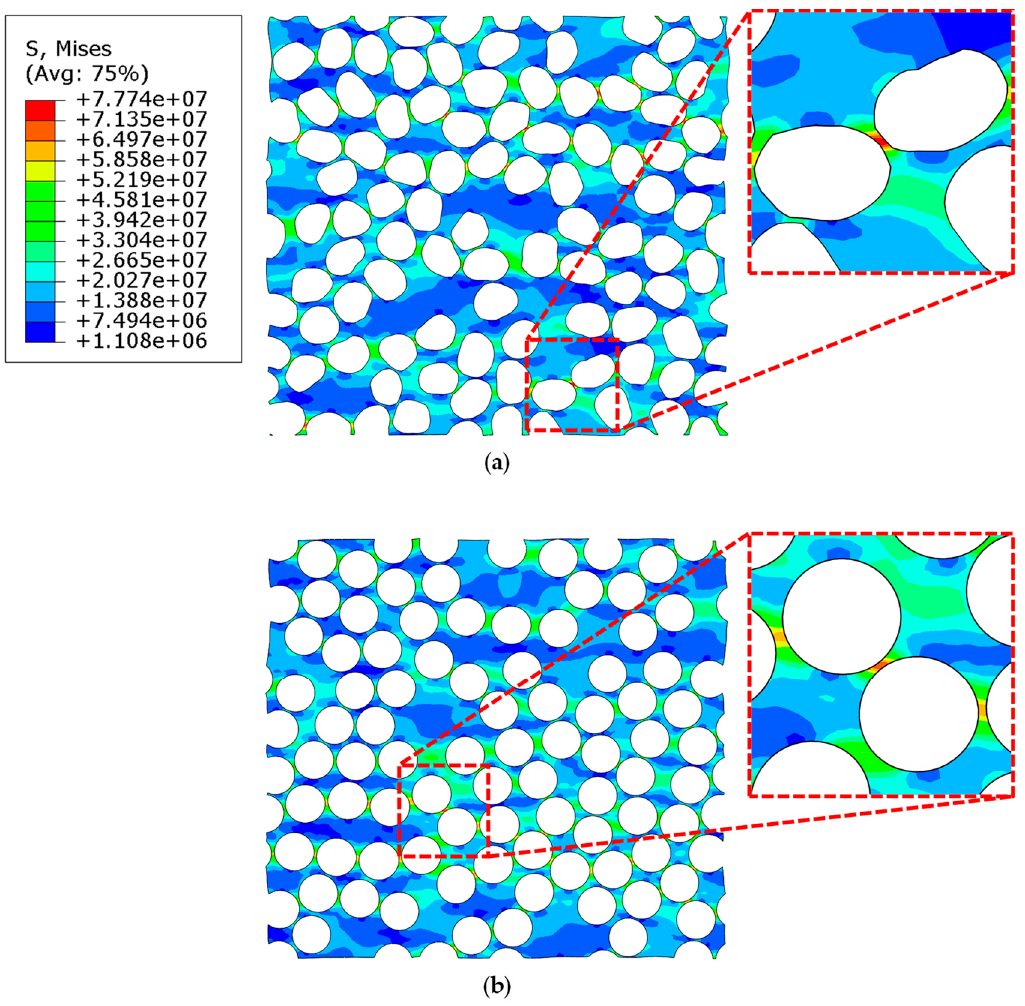
= 60% of T300/PR319: ( a ) RVEs with